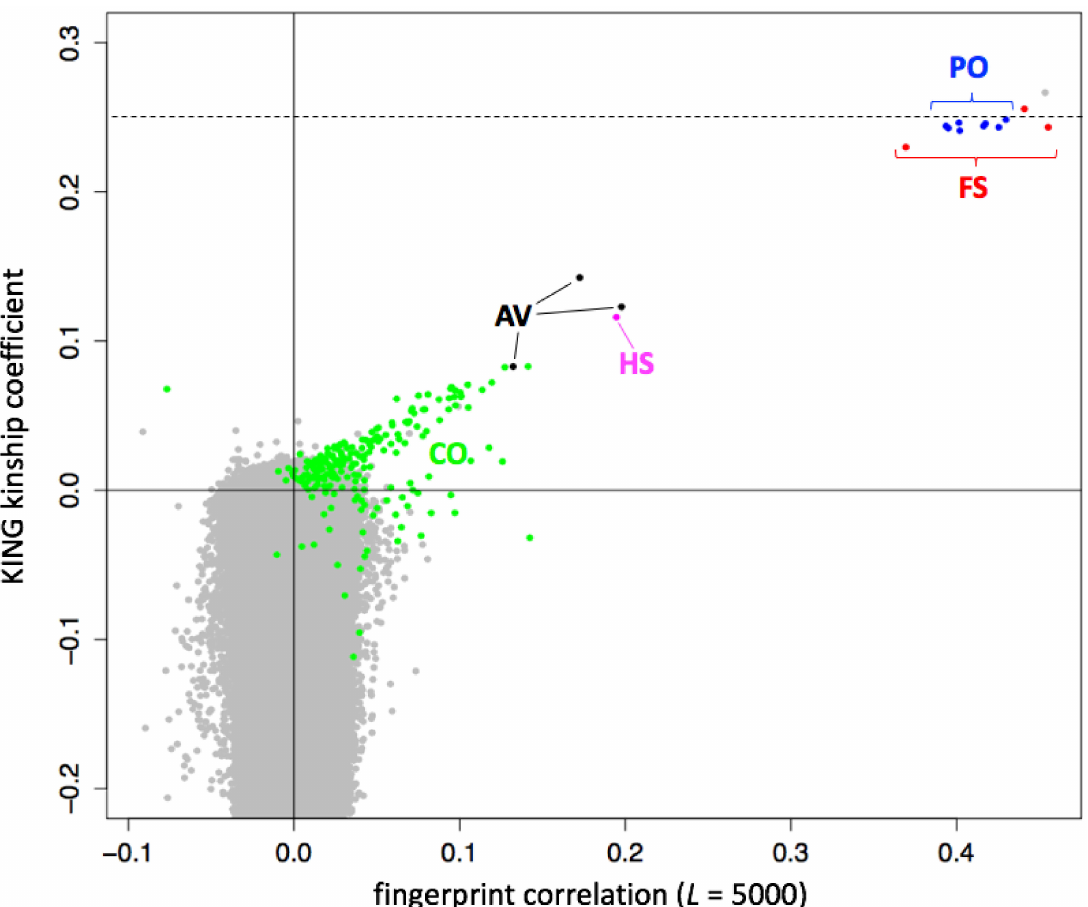
Figure 6. Identification of close relationships in the 1000 Genomes Project. Comparison between the correlations of population-adjusted genotype fingerprints (V3 set, L = 5000) and the kinship coefficient computed using KING, highlighting close relationships identified using RELPAIR. FS: full siblings (red). PO: parent/offspring (blue). HS: half siblings (magenta). AV: avuncular (black). CO: cousins (green). All other pairs in gray. One FS pair (HG03873 and HG03998, with maximal kinship, in gray) was not identified by